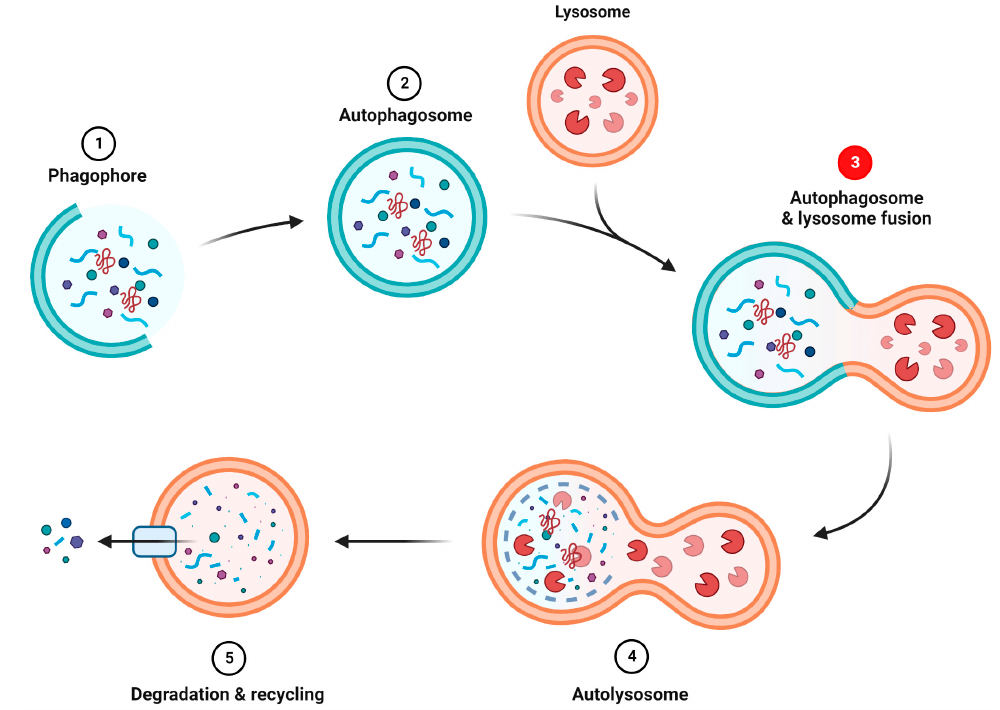
Figure 3. Summary of autophagy process. (1) Nucleation of the phagophore. (2) Elongation and maturation of the phagophore into an autophagosome. (3) Autophagosome fusion with lysosome. S1R seems to be involved in this step. (4) Formation of the autolysosome. (5) Degradation and recycling of the autolysosome